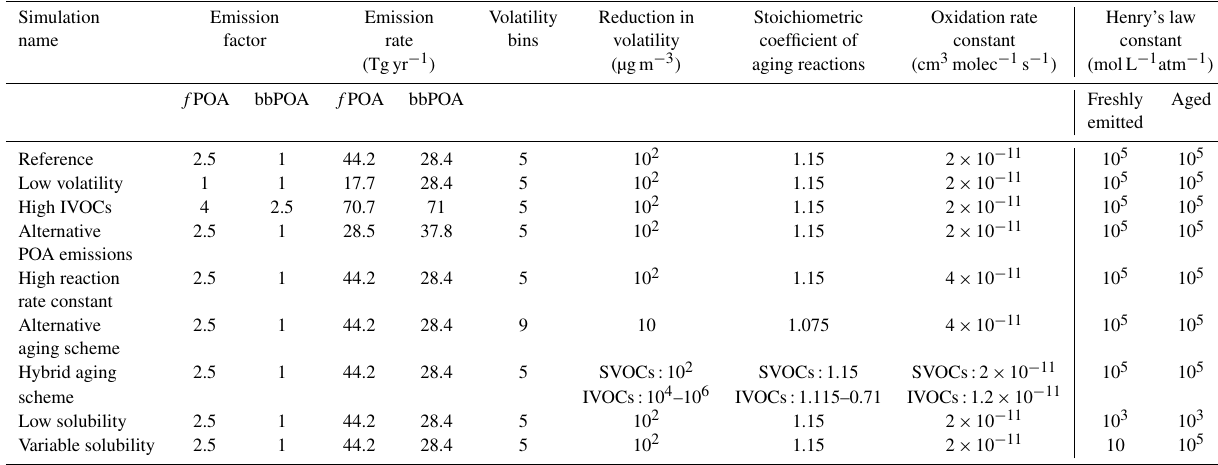
Table 1. Parameters used in the sensitivity simulations.